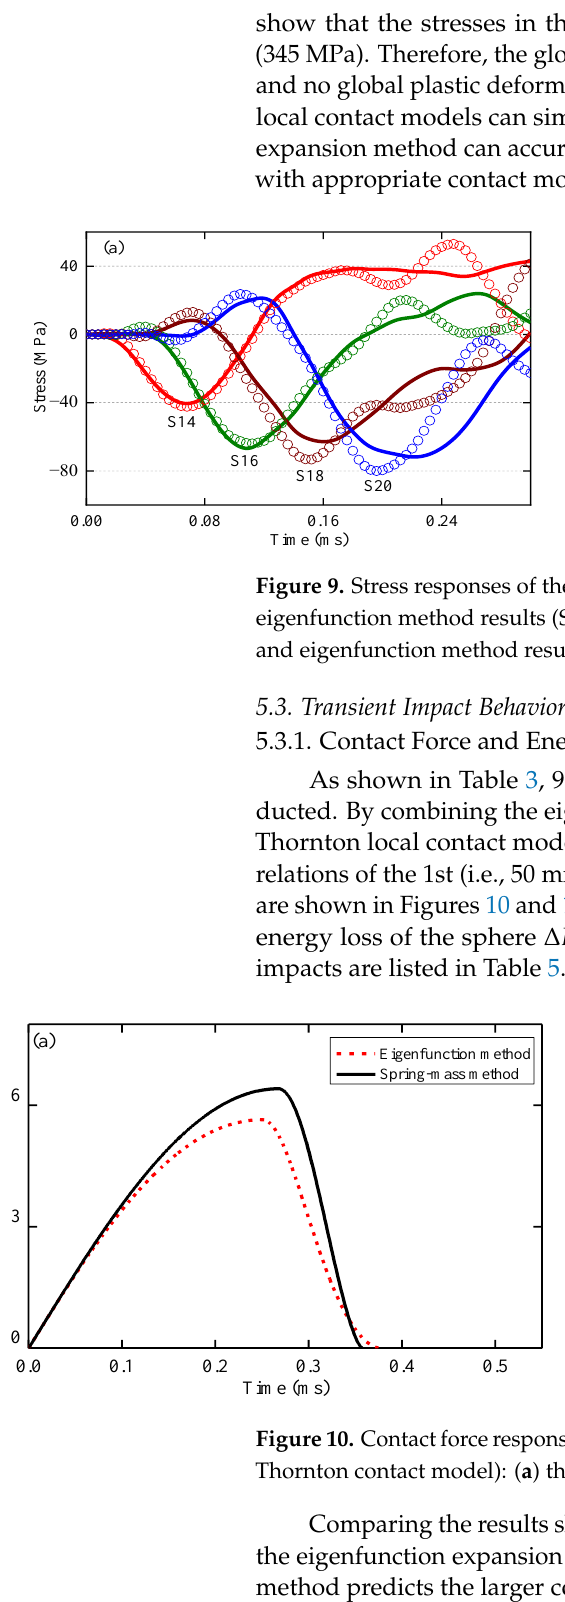
Figure 11. Contact force-Indentation relations by eigenfunction expansion method and spring-mass method (with Thornton contact model): ( a ) the 1st impact, V 01 = 0.990 m/s; ( b ) the 91st impact, V 091 = 2.656 m/s. Comparing the results shown in Figures 10 and 11 and Table 5, the differences be- tween the eigenfunction expansion method and spring-mass method are significant. Spring-mass method predicts the larger contact force, indentation, permanent indenta- tion, impulse and contact work, but the smaller impact duration and energy absorption of the beam. For spring-mass method, due to the neglecting of wave propagation energy, less energy is transferred to structural vibrations and more energy is transferred to local contact zone, which results in higher contact force and shorter impact duration. For the results of first impact shown in Figure 10a, the predicted contact force and impact dura- tion of spring-mass method are 13.30% higher and 4.12% shorter relative to eigenfunction method, respectively. For the results of 91st impact shown in Figure 10b, the predicted contact force and impact duration of spring-mass method model are 53.30% higher and 8.99% shorter relative to eigenfunction method, respectively. Therefore, higher modes of beam vibration should be taken into account to achieve a better estimation of the contact force and impact duration. 5.3.2. Impact Duration As shown in Figure 12a,b, the impact duration of the last impact for every impact velocity are analyzed. The impact duration predicted by eigenfucntion expansion method and spring-mass method are compared with the experimental results. The plots show that